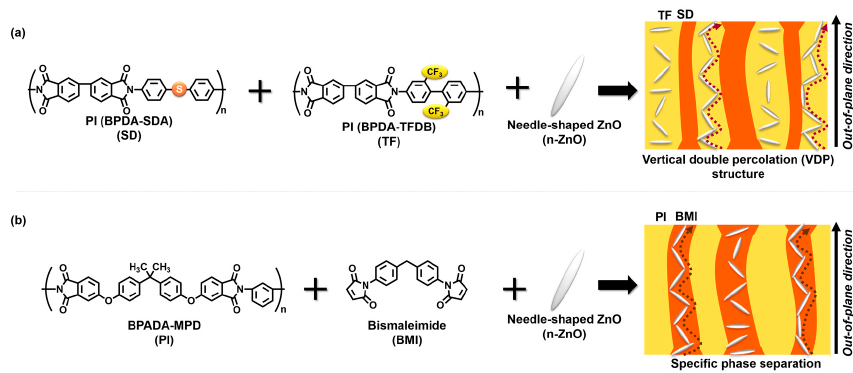
Figure 1. Specific morphology formed from phase separation of an immiscible ( a ) PI blend; and a ( b ) BMI/BPADA-MPD blend with needle-shaped ZnO (n-ZnO) particles. The red/brown arrows and the white ellipsoids represent directions of thermal conduction and n-ZnO particles,